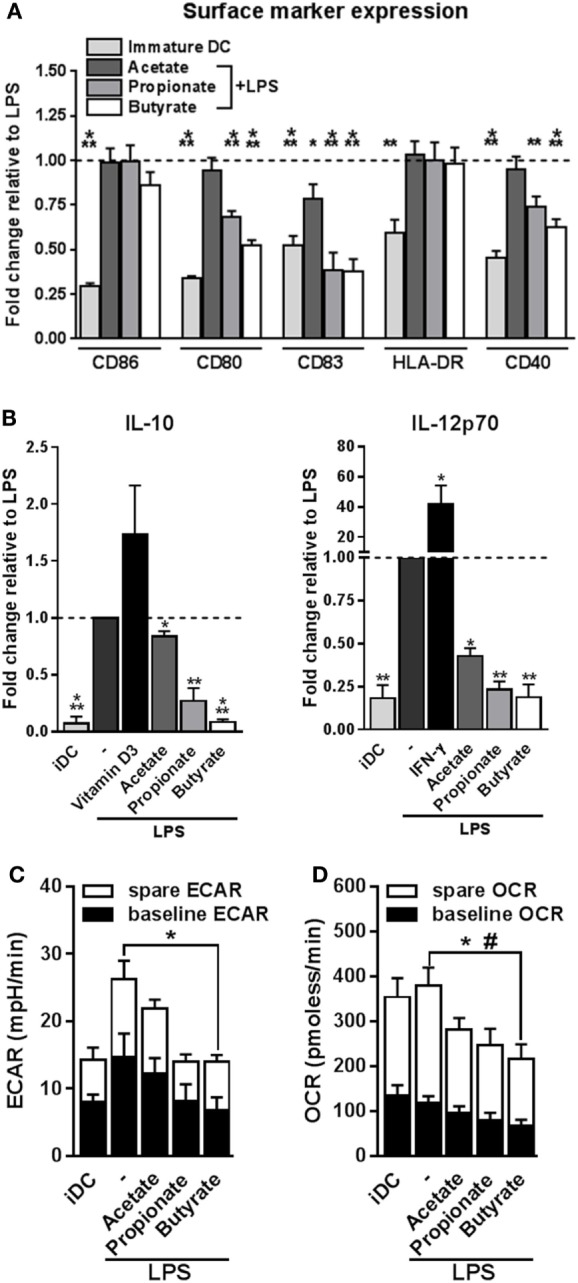
Butyrate suppresses LPS-induced activation and metabolic changes in human dendritic cells (DCs). (A,B) Monocyte-derived DCs were left untreated (iDC) or stimulated as indicated for 48 h after which (A) expression of maturation markers was analyzed by flow cytometry and (B) supernatants were collected and concentrations of indicated cytokines were determined by ELISA. (A) The expression levels of maturation markers are based on the geometric mean fluorescence and are shown relative to DCs stimulated with LPS, which was set to 1 for each marker (dashed line). (B) Vitamin D3 and IFN-γ-stimulated DCs were taken along as IL-10- and IL-12-inducing controls, respectively. (C,D) Metabolic phenotype of differently stimulated DCs was assed using a Seahorse extracellular flux analyzer. (C) Baseline and spare extracellular acidification rate (ECAR) were determined as described in Section “Materials and Methods,” with significant differences in baseline ECAR indicated with *. (D) Baseline and spare mitochondrial oxygen consumption rate (OCR) were determined as described in Section “Materials and Methods,” with significant differences in baseline or spare OCR indicated with * and #, respectively. (A–D) Bar graphs represent means ± SEM of at least five experiments. *,#p < 0.05, **p < 0.01, ***p < 0.001 based on paired Student’s t-test.